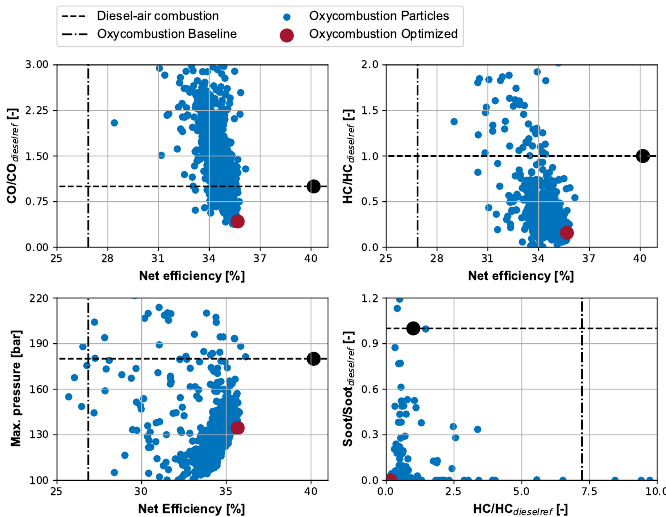
Figure 12. Pareto front of max. pressure of the engine vs. efficiency, CO emissions, HC. and soot evolution vs. efficiency. The pollutant emissions are normalized by the reference diesel case